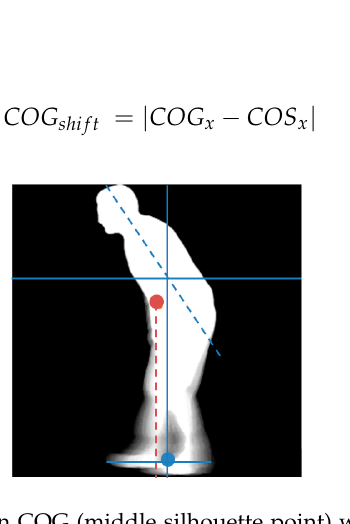
Figure 6. GEI highlighting shift in COG (middle silhouette point) with respect to the COS (lower silhouette point) and the orientation of the torso.